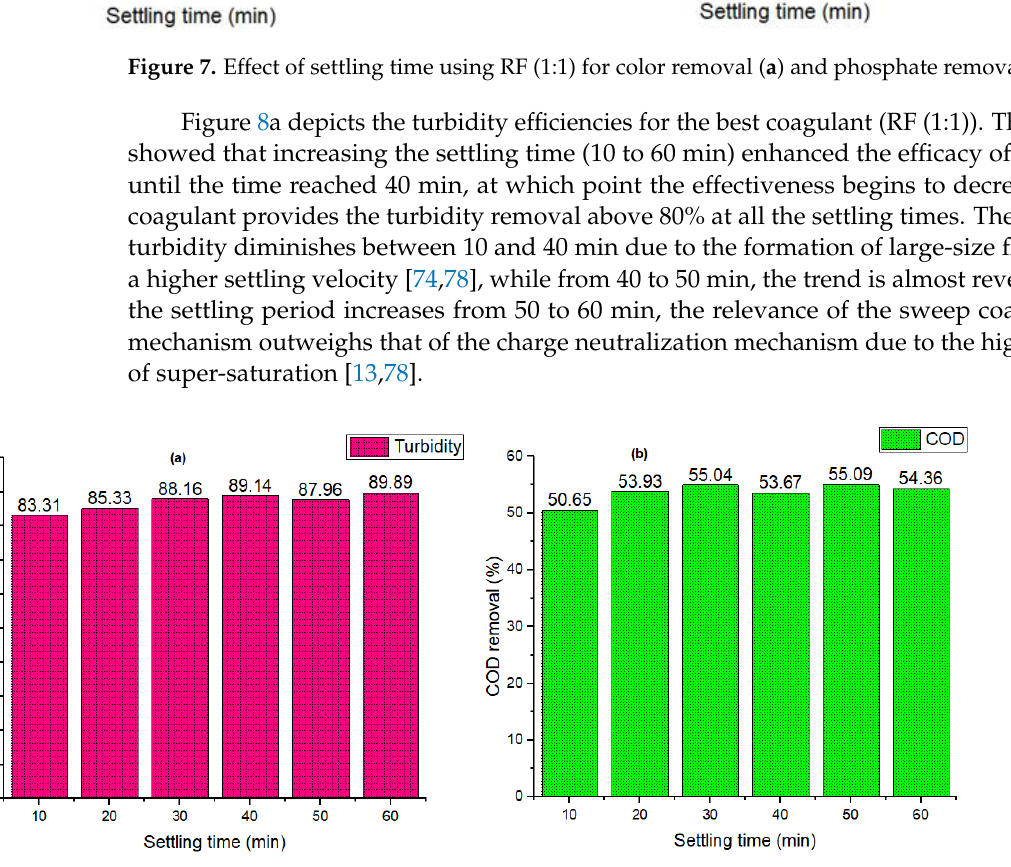
Figure 8. Evaluation of different coagulants on ( a ) turbidity removal (%), and ( b ) COD removal (%).